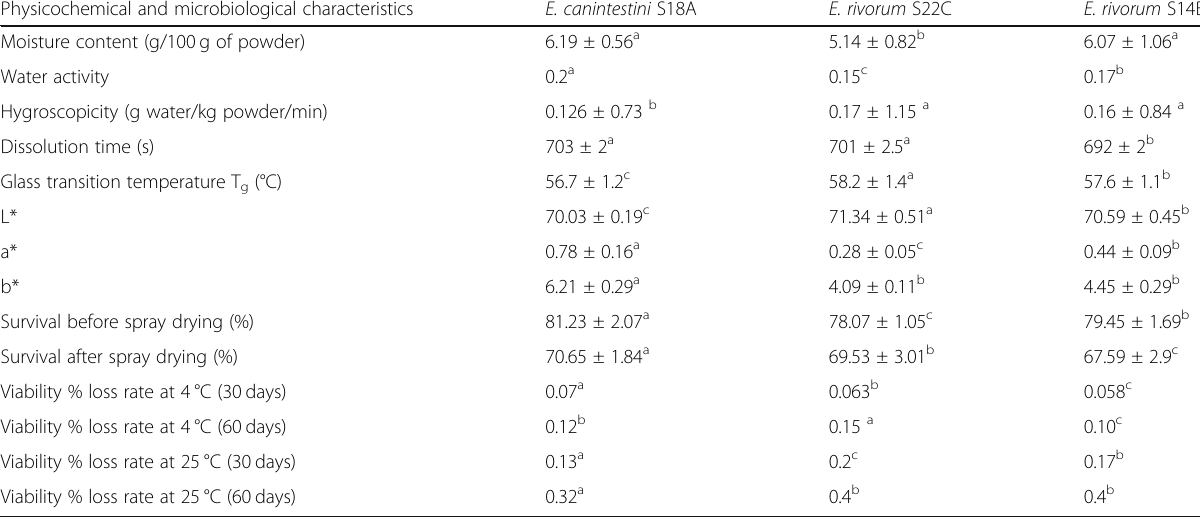
Table 1 Physicochemical and microbiological characteristics of spray-dried powder Physicochemical and microbiological characteristics